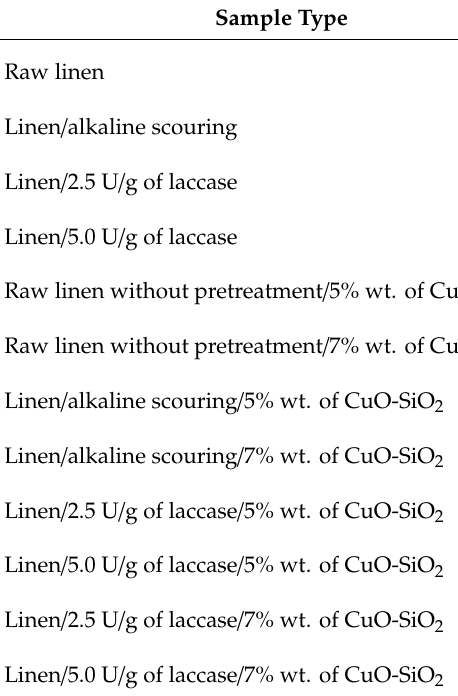
Table 1. Values of ultraviolet protection factor (UPF) and transmittance in the UVA (T UVA ) and UVB (T UVB ) range for linen woven fabrics after alkaline or enzymatic treatment and modification with inorganic hybrid.